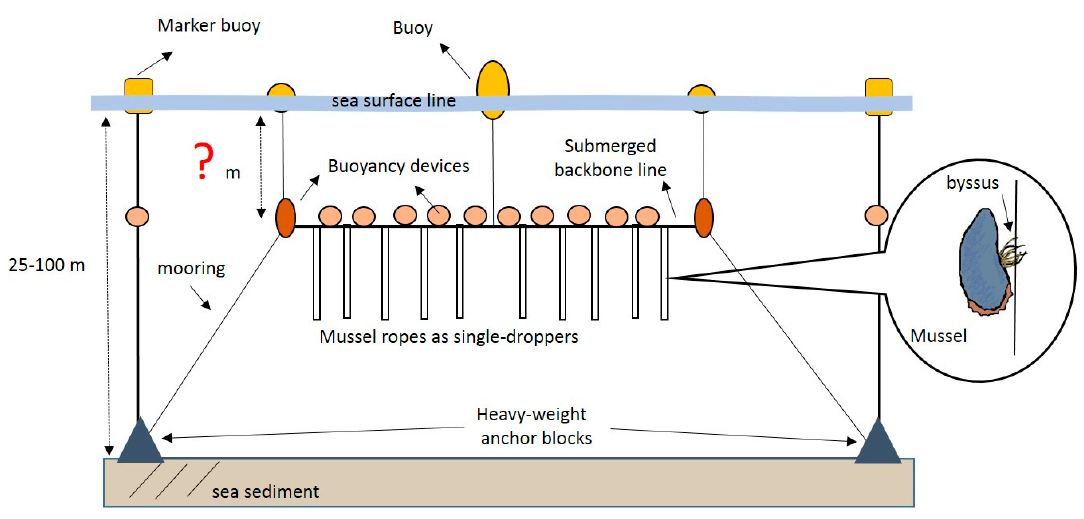
Figure 1. Scheme of offshore submerged longline system for mussels (based upon Goseberg et al. [8]; Langan & Horton [29]). The suitable area depth for offshore operation is indicated, whereas the suitable depth for submersion of mussel ropes in the water column is indicated by the symbol “?”, as it is one of the objectives of this paper.